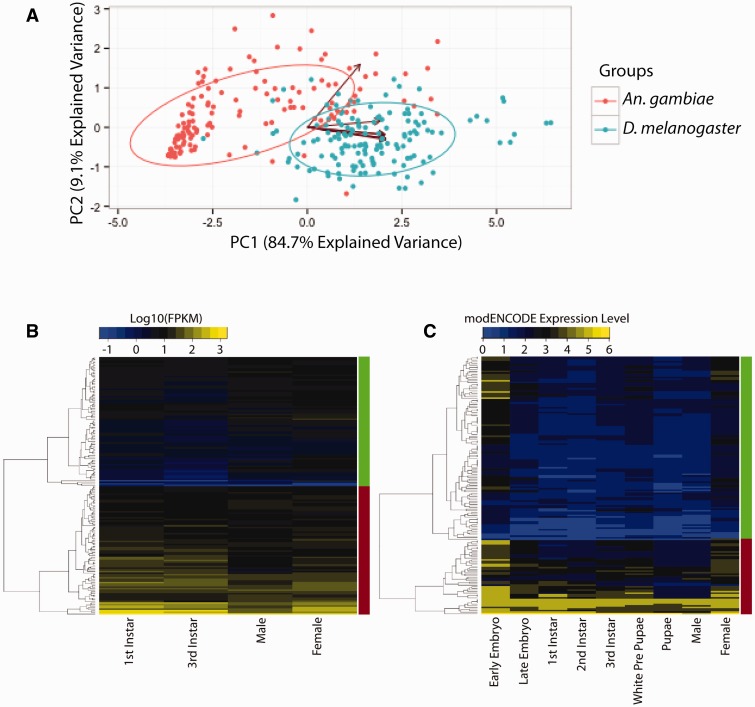
Epigenetic gene ensemble expression in tissues and development. (A) PCA (using prcomp function in R; R Core Team 2014) of Log10(epigenetic modifier gene expression) across tissues in D. melanogaster and A. gambiae. Expression values were obtained from modENCODE for D. melanogaster and MozAtlas for A. gambiae (Baker et al. 2011; Celniker et al. 2009). All values were normalized to Act5C to control for potential differences relating to magnitude of expression. Arrows indicate tissue-specific components. Topmost vector (30° off-vertical) represents testis expression, next vector clockwise (85° off-vertical) represents ovary expression, whereas clustered vectors (95° off-vertical) represent carcass, midgut, ovary, head, Malpighian tubules, and salivary gland expression. (B) Hierarchical clustering of expression of epigenetic gene ensemble members in A. gambiae based on RNA sequencing data across four life stages (mixed gender L1, mixed gender L3, adult male, and adult female) (Jenkins et al. 2014; Jenkins and Muskavitch 2015). Clustering was performed using Pearson correlation with complete linkage distances. Red bars indicate clustering of the “high expression” gene class (84 genes); green bars indicate the “low expression” gene class (85 genes). (C) Hierarchical clustering of expression of homologous epigenetic gene ensemble members in D. melanogaster based on expression levels identified by modENCODE and listed in FlyBase 5.48 (St Pierre et al. 2014; Celniker et al. 2009). Red bars indicate high expression gene class (50 genes); green bars indicate low expression gene class (119 genes). Comparing heights of same colored bars between panels (B) and (C) reflects the relative number of genes for each class, in each species.